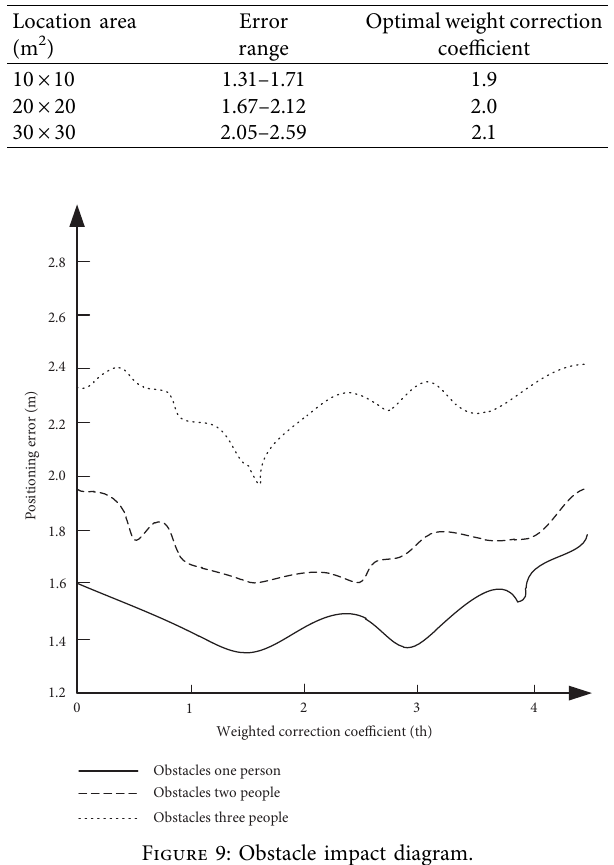
Table 1: Static weight correction coefficient correction results of positioning area size.